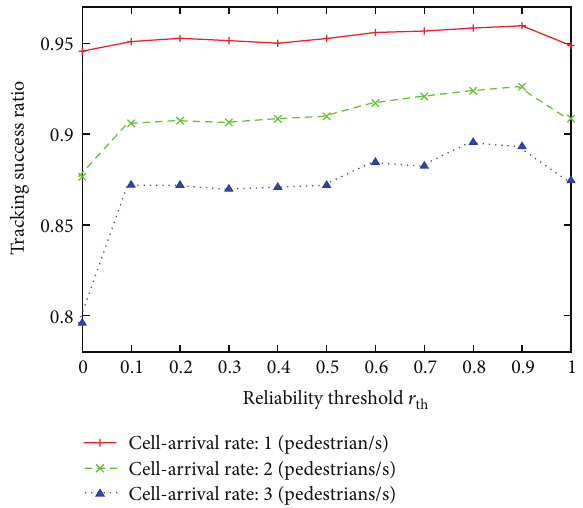
Figure 11: Tracking success ratio plotted against the distribution of gate transition probabilities.